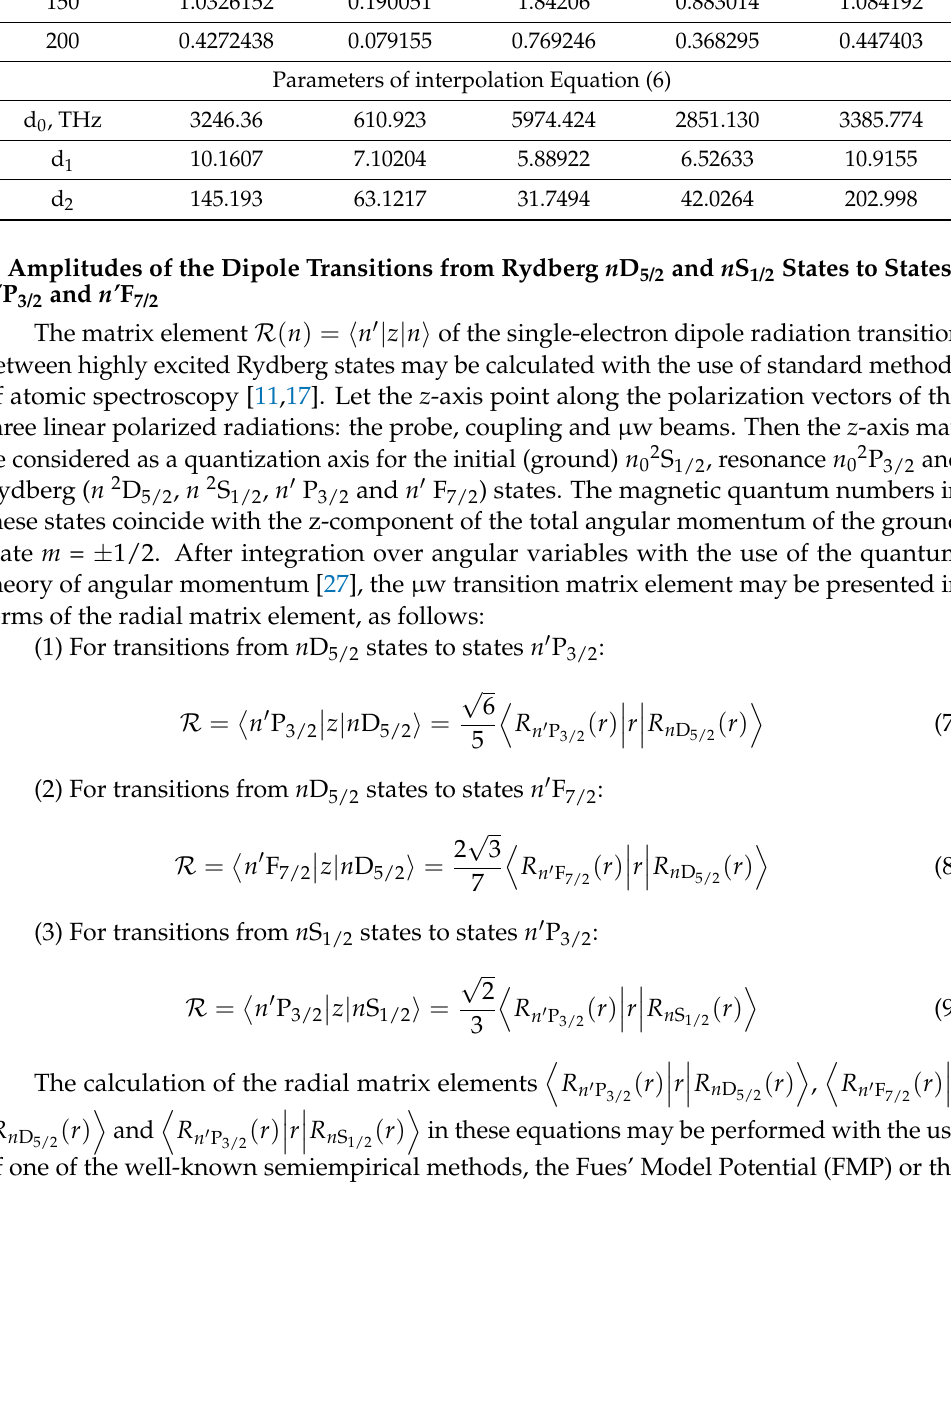
Table 6. Frequencies of electric dipole transitions in Cs atoms: from state n P 3/2 to the n S 1/2 state, ∆ E = E − E n PS n P 3/2 n S 1/2 ; from state n D 5/2 to the ( n + 1 )P 3/2 state, state ( n + 2)P 3/2 to state n D 5/2 , ∆ E n PD = E ( n + 2 ) P